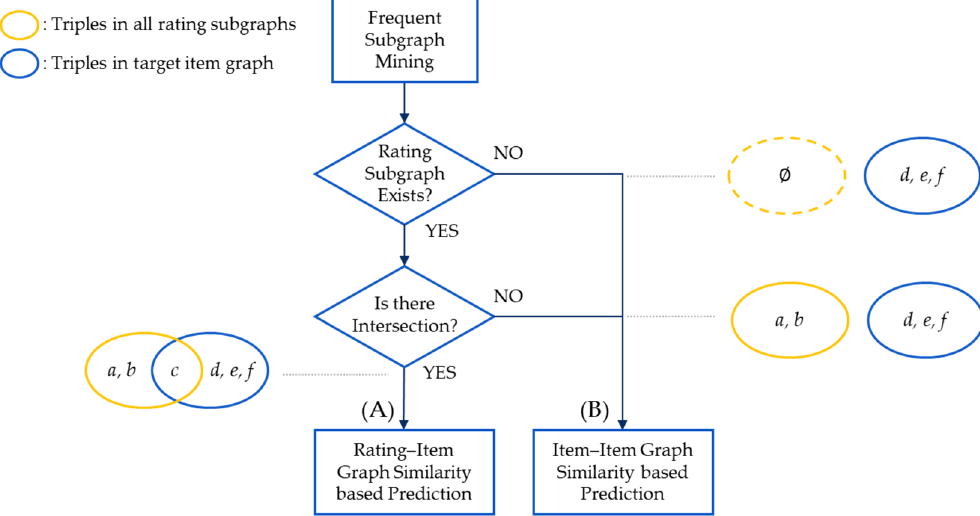
Figure 19. Rating prediction cases.